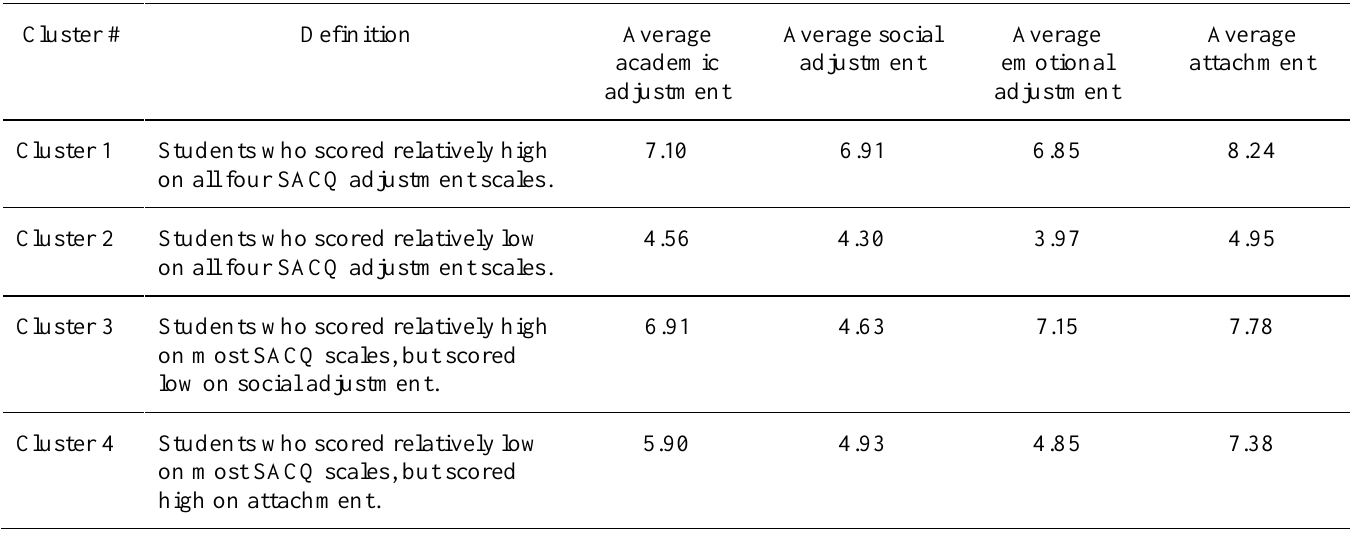
Average social Average Average academic adjustment emotional attachment adjustment adjustment